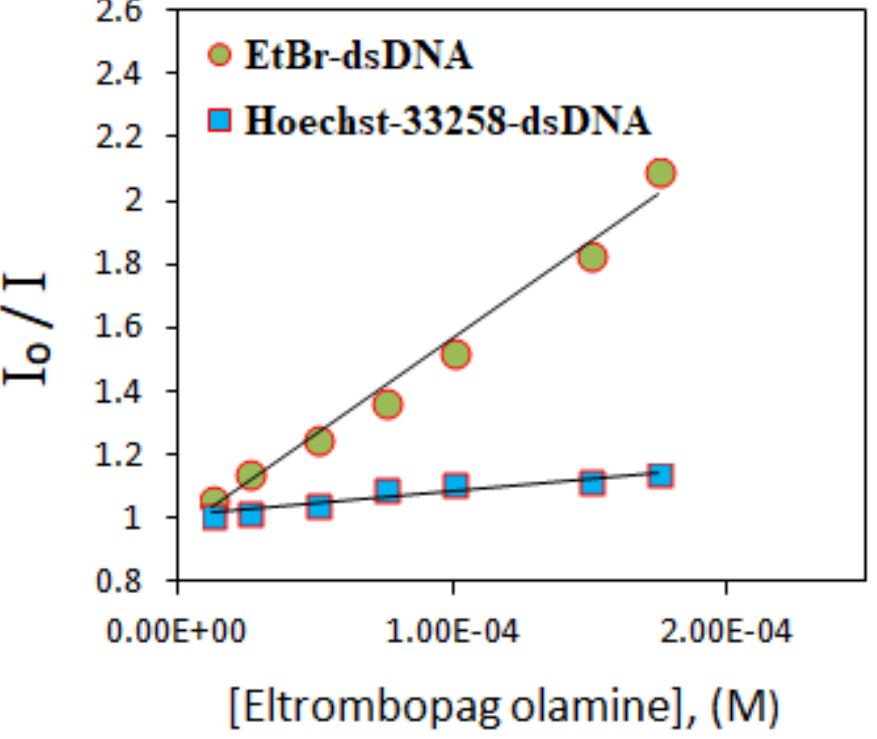
Figure 9. Stern–Volmer plots show the fluorescence quenching of different dye-dsDNA solutions by the increasing addition of ELT. ( R 2 = 0.9879 for EtBr–dsDNA, R 2 = 0.9932 for Hoechst-33258–dsDNA). The K sv values were calculated from the slopes of the plots and found to be 6.12 × 10 3 ± 0.12 M − 1 and 7.13 × 10 2 ± 0.20 M − 1 for EtBr and Hoechst-33258, respectively. A